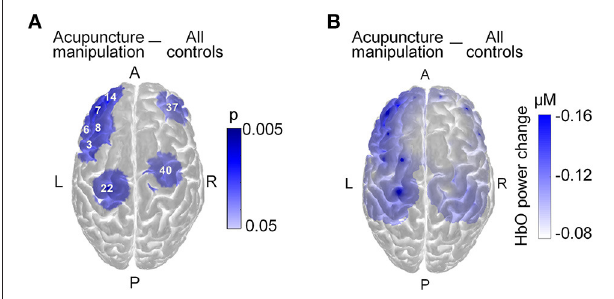
Supplementary Figure S2 | Acupuncture responsive areas. (A) Locations and mapping of the significantly decreased acupuncture responsive channels ( n = 8, the digital number for acupuncture response channel, two-sample t -tests, FDR correction for multiple comparisons, alpha = 0.05 and statistical power > 0.95, visualized by p -value, blue color for decrease). (B) Mapping of the group-averaged HbO power change for acupuncture manipulation vs. all